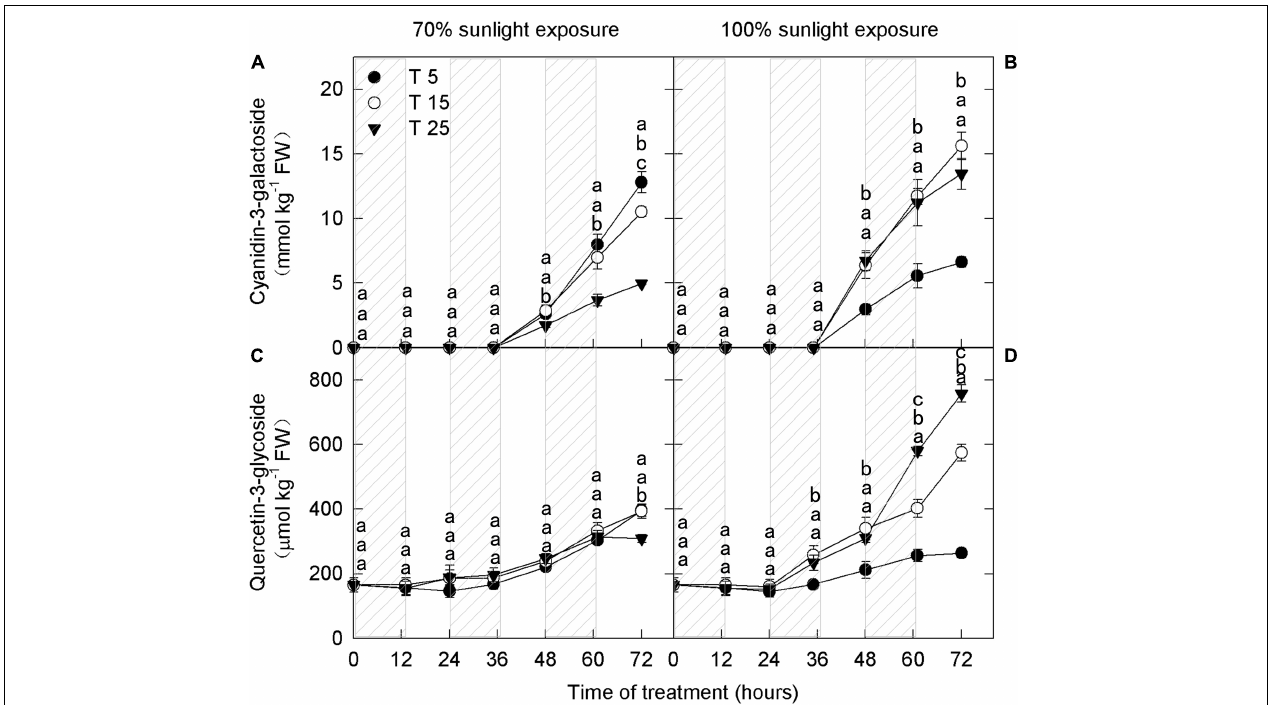
FIGURE 1 | Concentrations of cyanidin-3-galactoside and quercetin-3-glycoside in the peel of “Fuji” apples exposed to different nighttime temperatures and sunlight intensities. Concentrations of cyanidin-3-galactoside in the peel of “Fuji” apples exposed to nighttime temperatures of 5, 15, and 25 ◦ C and 70% sunlight intensity (A) and 100% sunlight intensity (B) . Concentrations of quercetin-3-glycoside in the peel of “Fuji” apples exposed to nighttime temperatures of 5, 15, and 25 ◦ C and 70% sunlight intensity (C) and 100% sunlight intensity (D) . Different lowercase letters indicate significant difference among treatments at P <